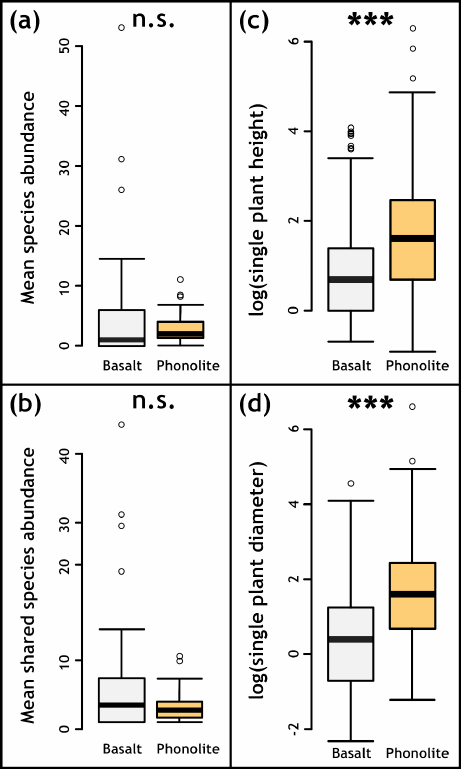
Figure 4. (a) Mean abundance differs significantly between basaltic ( n = 60) and phonolite substrates ( n = 60), but (b) considering only shared species on both substrates resulted in no significant differ- ence between basalt ( n = 39) and phonolite ( n = 51). (c, d) plant height and diameter (both log10-transformed) are significantly larger on phonolite plots ( n = 1560) than on basaltic plots ( n = 1173). Plot size: 2 × 2m. All analyses were conducted with the Mann–Whitney U